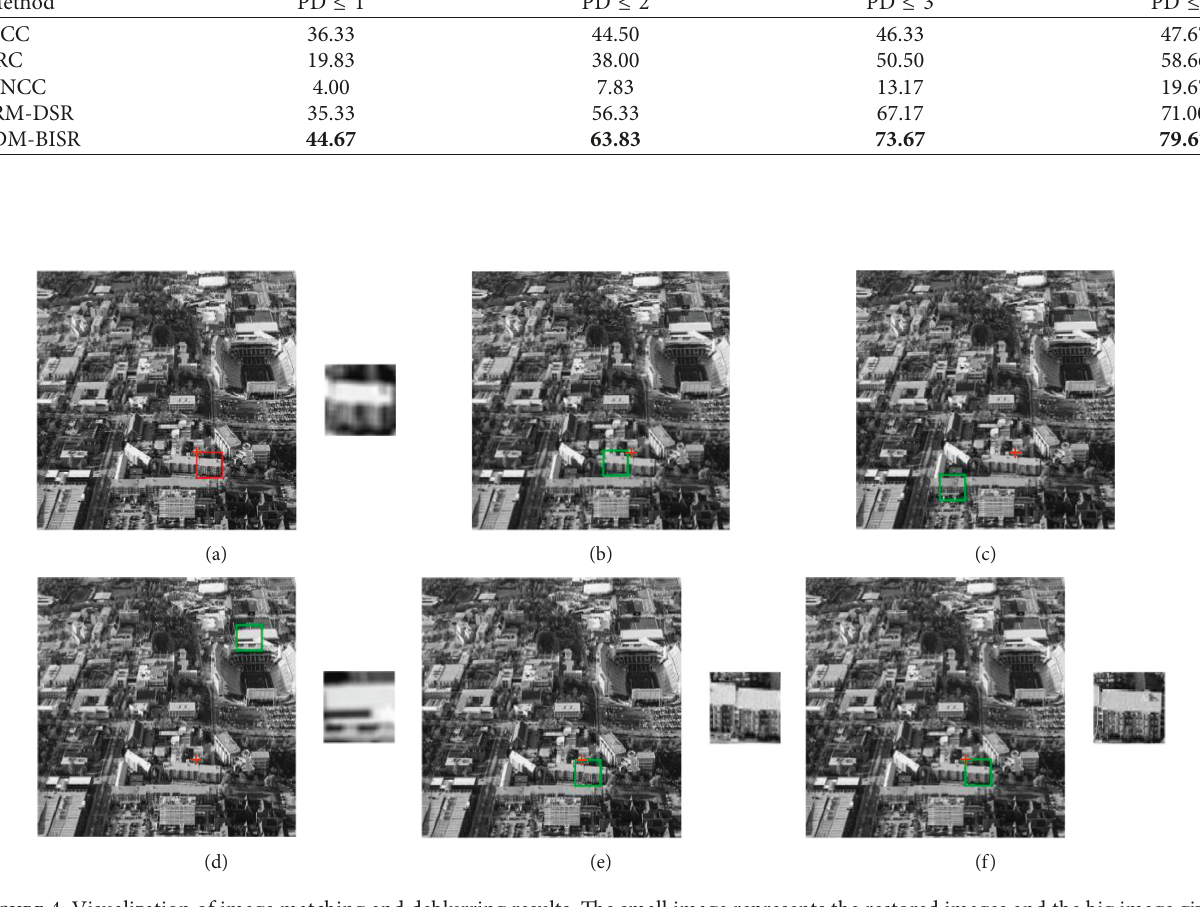
Figure 4: Visualization of image matching and deblurring results. The small image represents the restored images and the big image gives the matching results, where the red rectangle represents the ground truth of the matching position, the red cross ( + ) represents the top-left coordinate of it, and the green rectangle means the predicted matching position. (a) Reference image and blurry input image. (b) Results of NCC. (c) Results of SRC. (d) Results of DNCC. (e) Results of JRM-DSR. (f) Results of